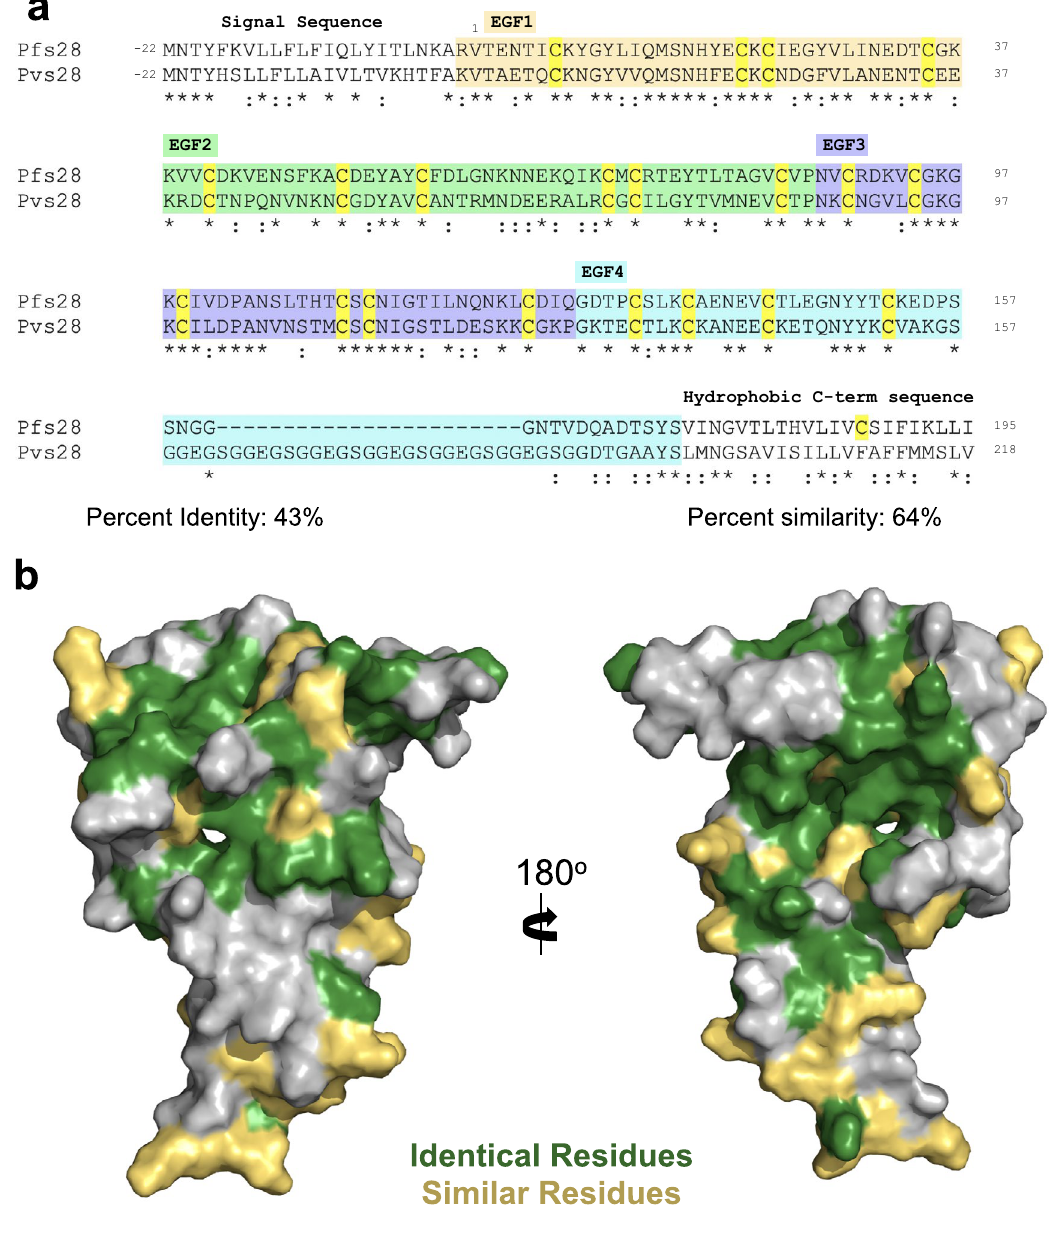
Figure 2. Sequence similarity between Pfs28 and Pvs28. ( a ) Sequence alignment of Pfs28 and Pvs28 generated using Clustal Omega 30,31 and shaded in wheat, green, purple, and blue according to EGF-like domain. Identical residues indicated with ‘*’ and chemically similar residues indicated with “:” Cysteines are highlighted in yellow. ( b ) Surface representation of Pfs28 (grey) with identical residues colored green and chemically similar residues colored